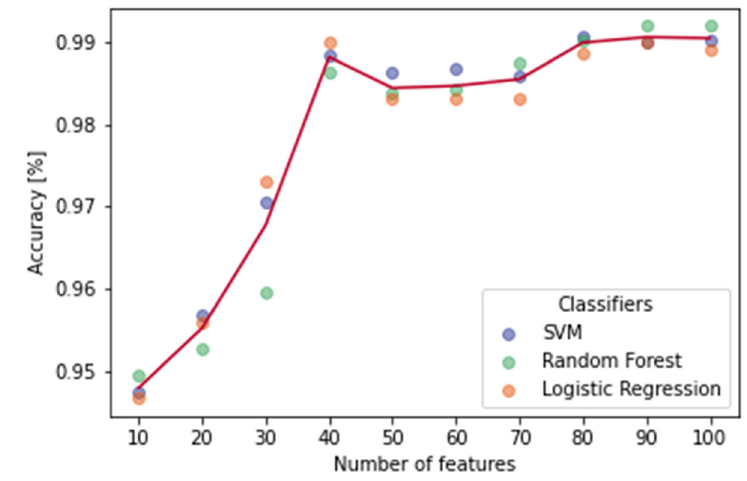
Figure 4. Mean accuracy performances of the three classifiers displayed for each value of the total number of features. Each data point is the mean value of 20 values obtained by shuffling the data.